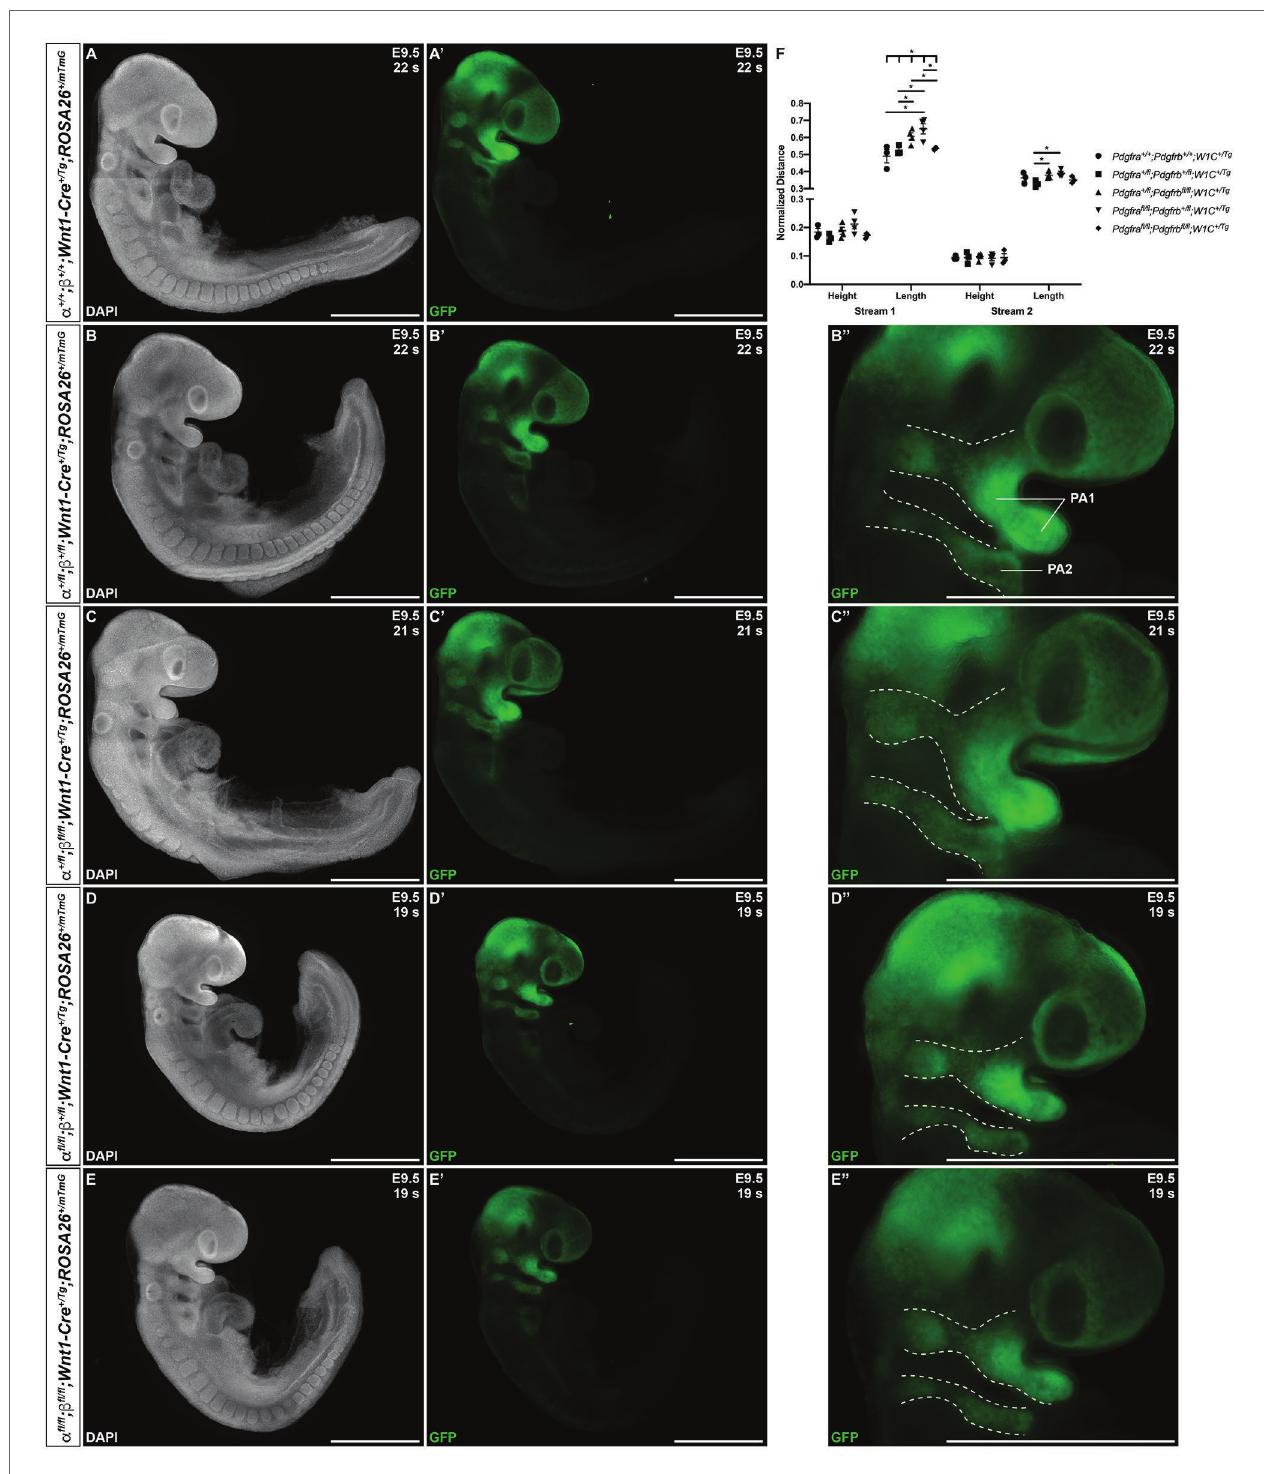
FIGURE 3 | Ablation of Pdgfra and Pdgfrb in the NCC lineage leads to longer cranial NCC (cNCC) streams entering pharyngeal arch 1 (PA1) and pharyngeal arch 2 (PA2) at E9.5. (A–E ' ) Lateral, whole-mount fluorescence images of 4’,6-diamidino-2-phenylindole (DAPI; A–E ) and GFP (A ' –E ' ) expression across five genotypes at E9.5. (B '' –E '' ) Zoomed-in images of GFP expression in cNCC streams (outlined by dotted lines) entering PA1 and PA2. PA1, pharyngeal arch 1; PA2, pharyngeal arch 2. (F) Scatter dot plot depicting the normalized anterior-posterior heights and dorsal-ventral lengths of cNCC streams entering PA1 and PA2 across five genotypes at E9.5. Data are presented as mean ± SEM. * p <